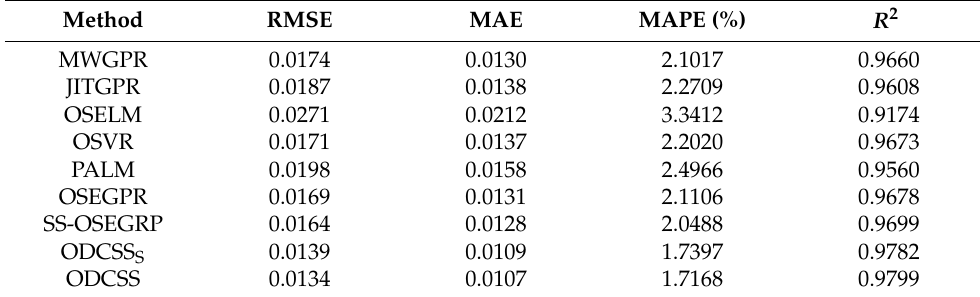
Table 2. Comparison of different soft sensor methods for prediction of TE composition in stream